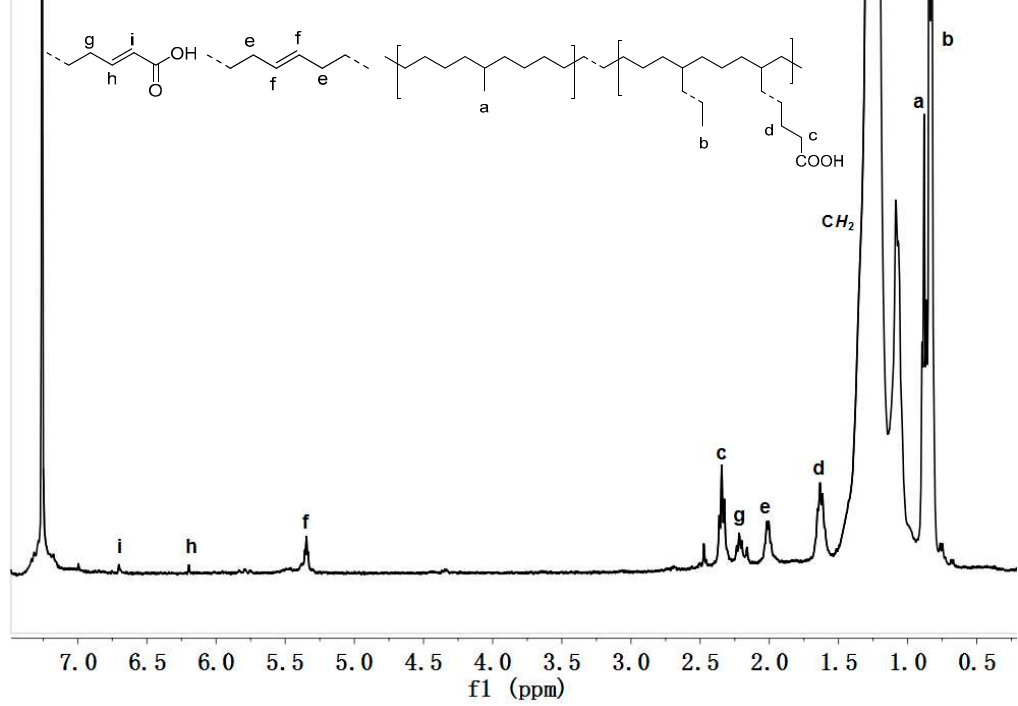
Figure 1. 1 H-NMR spectra of the copolymer obtained by Pd(II) catalyst (CDCl 3 , sample from Table 2, entry 10).